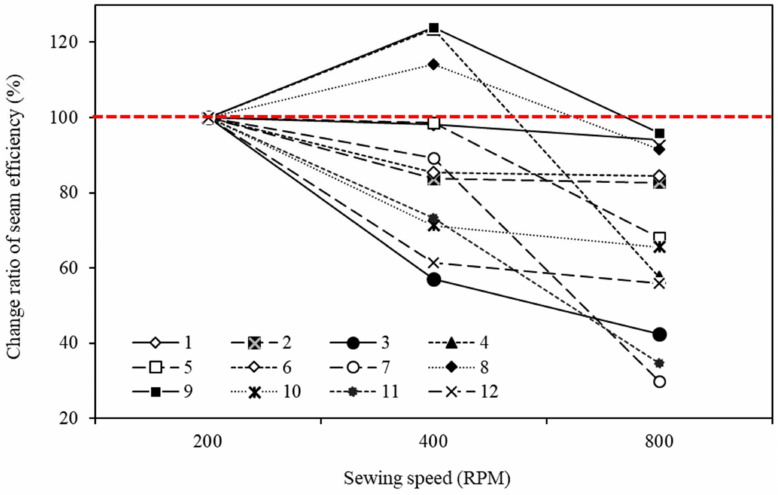
Figure 8. Change ratio of seam efficiency in lock stitch pattern according to sewing speed. Table 5. Sewability of the zigzag stitch on each fabric according to the sewing